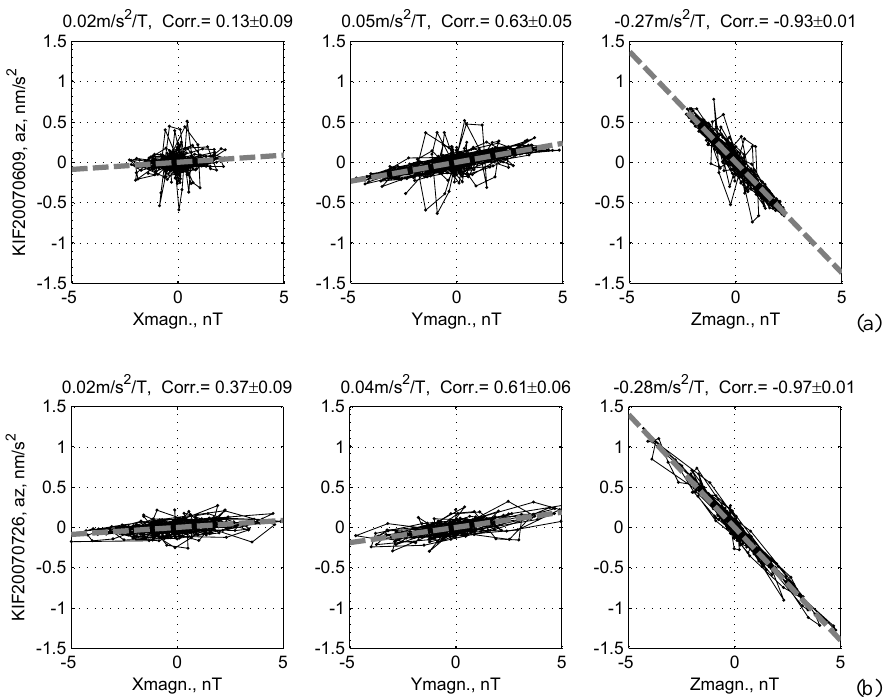
Fig. 12. (a) Result of the multi-factor analysis for the case of Pc4 pulsations recorded in Kilpisj¨arvi. Each panel shows correlation of the signal at Z -component of the STS-2 seismometer with one of the three components of the magnetic field. (b) Same as Fig. 11, but for the case of Pi2 pulsations observed in Kilpisj¨arvi on 26 July